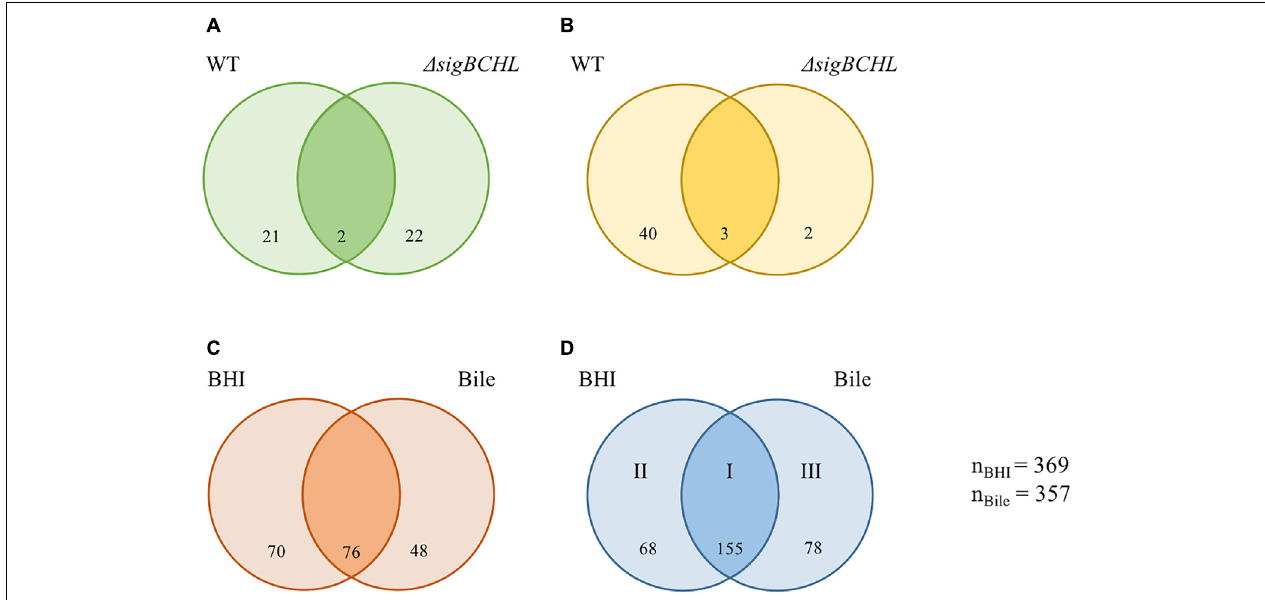
FIGURE 2 | Venn diagrams showing the overlaps of differentially expressed genes (DEGs) of L. monocytogenes wild type and (cid:49) sigBCHL under bile exposure compared to BHI. (A,B) Numbers of genes with significantly decreased and increased transcripts after exposure to bile, respectively. (C,D) Numbers of genes under σ A regulation with significantly lower and higher levels in (cid:49) sigBCHL in comparison to wild type, respectively. Differentially expressed genes in BHI and bile conditions are shown in left and right circles, respectively. The number indicated in the circle represents the number of differentially expressed genes in each strain and condition. I, II, and III represent groups of genes positively regulated by σ A . The total numbers of differentially expressed genes under BHI and bile calculated from either lower or higher level are 369 and 357,